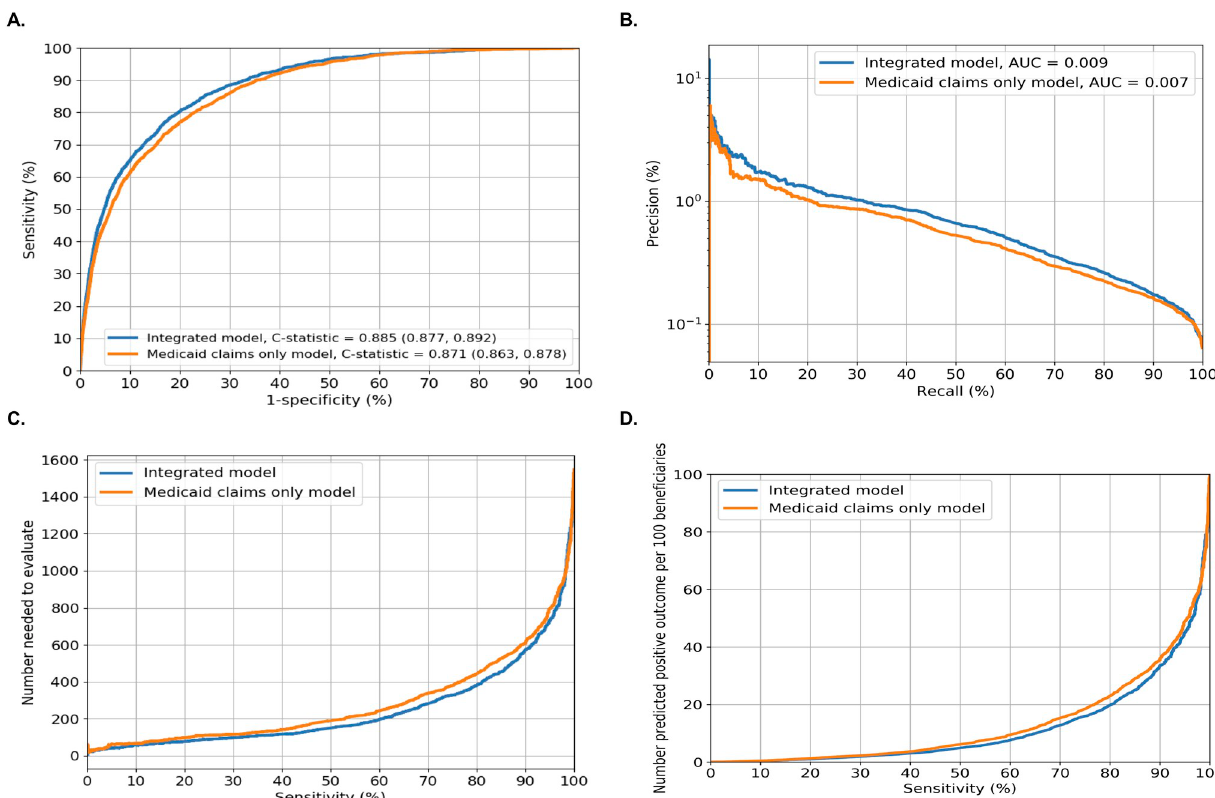
Fig 1. Performance matrix for predicting opioid overdose using gradient boosting machine in the integrated model vs. Medicaid claims only model in Allegheny County, Pennsylvania USA. Fig 1 shows four prediction performance matrices in the validation sample (79,086 beneficiaries with 2,700,425 non-overdose episodes and 1,748 overdose episodes). Fig 1A shows the areas under the ROC curves (or C-statistics); Fig 1B shows the precision-recall curves (precision = PPV and recall = sensitivity): Precision recall curves that are closer to the upper right corner or are above another method have improved performance; Fig 1C shows the number needed to evaluate by different cutoffs of sensitivity; and Fig 1D shows alerts per 100 patients by different cutoffs of sensitivity. Abbreviations: AUC : Area under the curves; GBM : Gradient boosting machine; ROC: Receiver Operating